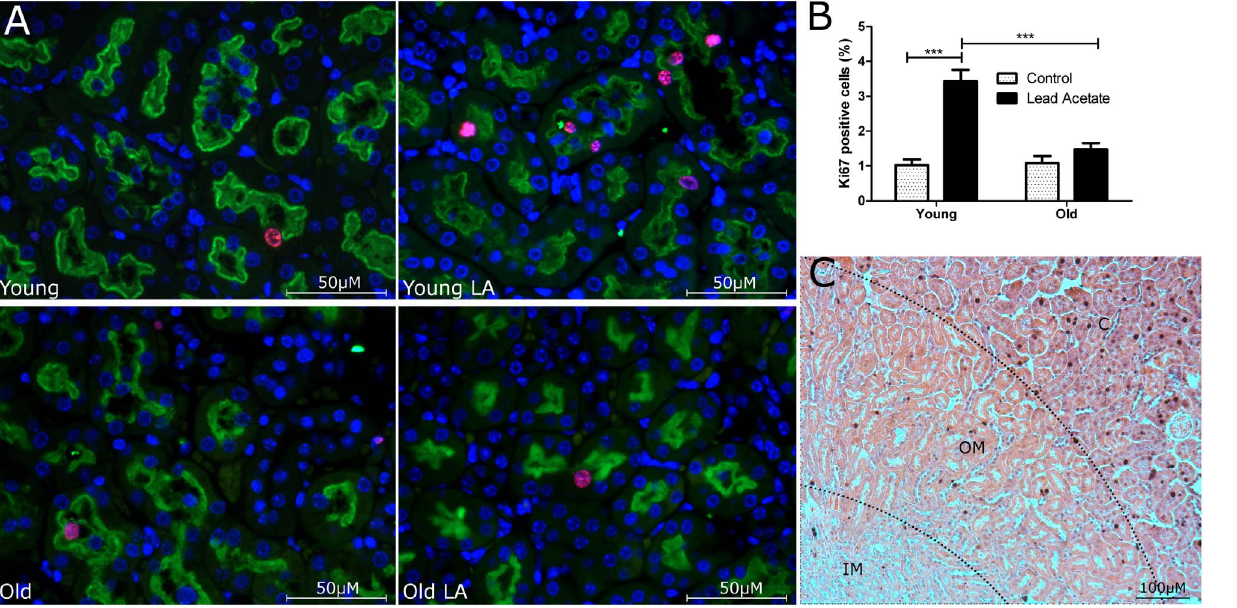
Figure 2. Lead acetate induces tubular cell proliferation in young but not old kidneys. Old and young mice were sacrificed 36 hours after exposure to 10 mg/100 g body weight lead acetate. (A) Representative Ki-67 (red) and LTL (green) immunostaining of kidney sections from young and old mice with or without lead acetate treatment; original magnification 400 6 . (B) Quantification of Ki-67 positive cells; (C) representative immunostaining of Ki-67 showing the segments of the kidney (C represents cortex, OM outer medulla and IM inner medulla). n=5, data are mean values 6 SEM. ***P , 0.001.